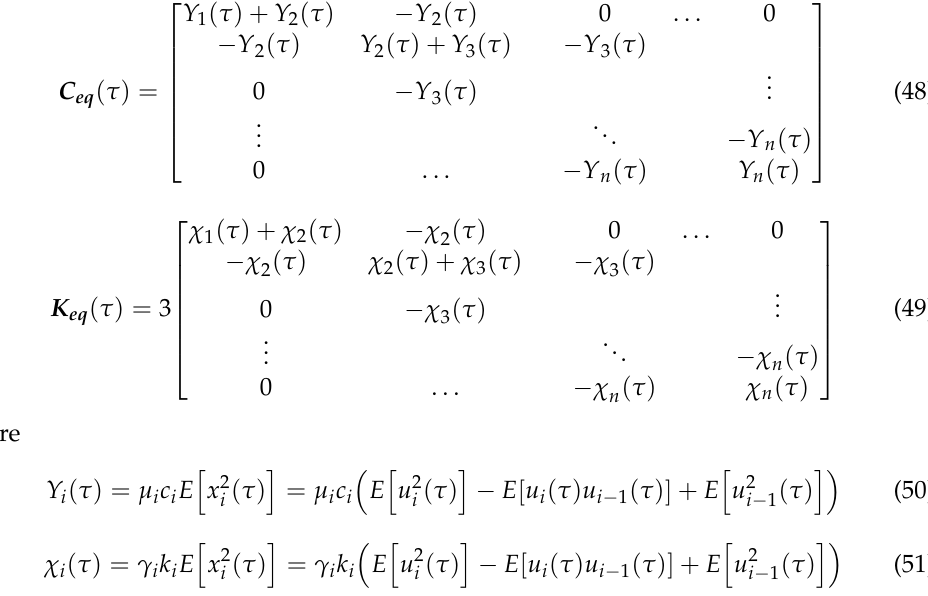
where 𝑢̈ 𝑖 , 𝑢̇ 𝑖 and 𝑢 𝑖 (𝑖 = 1, 2, … , 𝑛) are, respectively, the horizontal acceleration, veloc- ity and displacement of the i-th floor. 𝑷(𝑡) = 𝝓𝑾(𝑡) , where 𝝓 is the orientation matrix of the nonstationary zero-mean Gaussian random excitation 𝑾(𝑡) and the nonlinear terms 𝑮(𝑡) and 𝑳(𝑡) can be expressed as